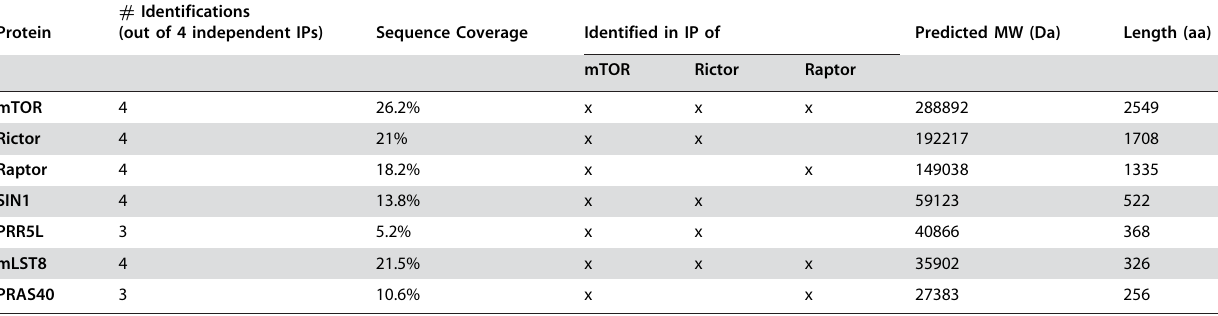
Table 1. mTORC1 and mTORC2 associated proteins identified by 2D-LC-MS/MS .. ... .... ... ... .... ... ... .... ... ... .... ... ... .... ... ... .... ... ... .... ... ... .... ... ... .... ... ... .... ... ... .... ... ... .... ... ... .... ... ... .... ... ... .